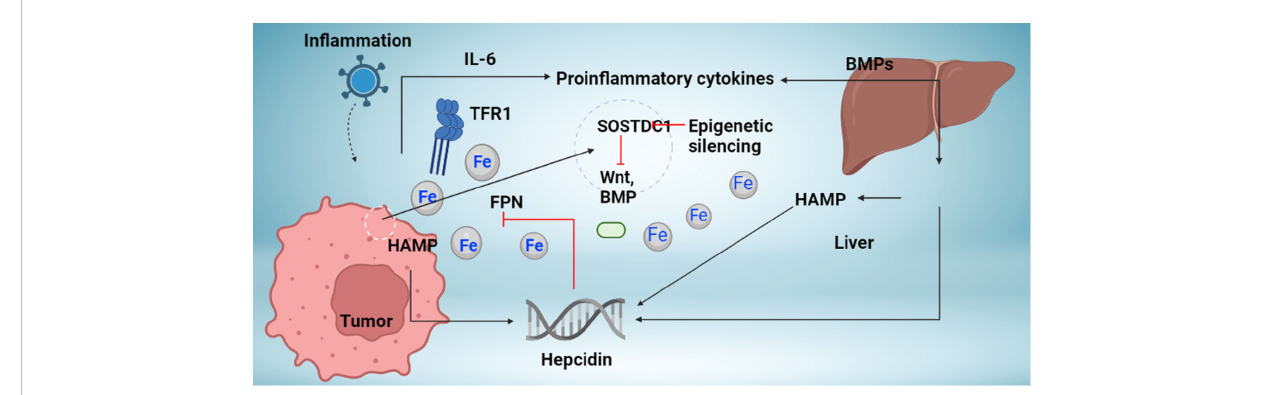
FIGURE 1 Mechanism regulation hepcidin synthesis in cancer. The liver and local tumor cells in cancer tissue produce hepcidin. Different bone morphogenetic protein (BMP) molecules, including BMP7, and in fl ammatory triggers, like interleukin-6, are associated with hepcidin overexpression in tumor tissue (IL-6). Studies indicate the presence of novel hepcidin regulators in cancer tissue, including the Wnt pathway and the sclerostin domain-containing protein 1 (SOSTDC1), which is downregulated in cancer due to epigenetic silencing (which is upregulated in cancer). Increased hepcidin in the tumor microenvironment causes ferroportin to behave in a way that causes iron sequestration in tumor cells (FPN). TFR1 overexpression, which increases iron availability to tumor cells, occurs concurrently with an increase in hepcidin. Increased iron depots aid tumor cells in surviving and